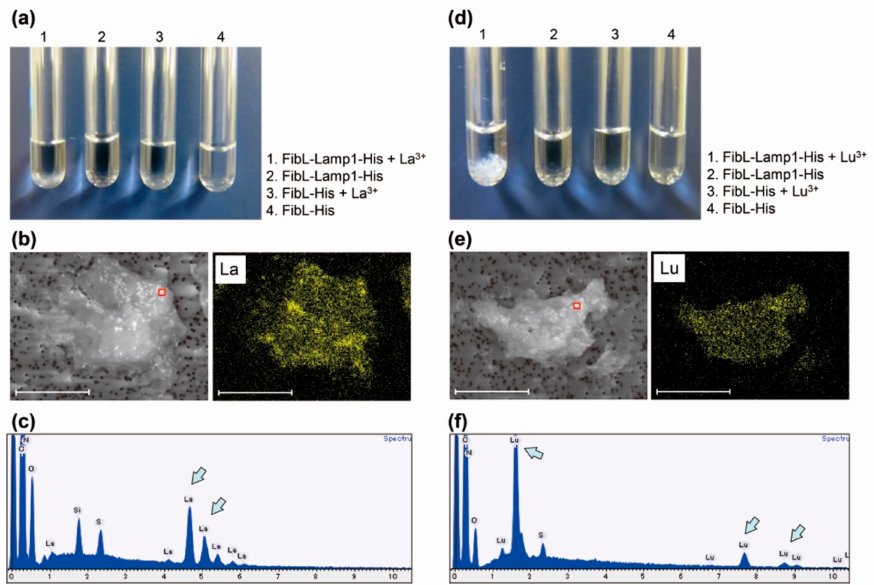
Figure 3. La 3 + and Lu 3 + recognition with the purified FibL-Lamp1-His protein. ( a – c ) Reaction with La 3 + , and ( d – f ) reaction with Lu 3 + . ( a – d ) Optical image of precipitation induced by the purified FibL-Lamp1-His protein. ( b – e ) SEM image (left) and elemental mapping image (right) of precipitation. Scale bars, 100 µ m. ( c – f ) EDX spectrum. The red frame area in the SEM image was analyzed. Each arrow indicates the spectrum of La or Lu.